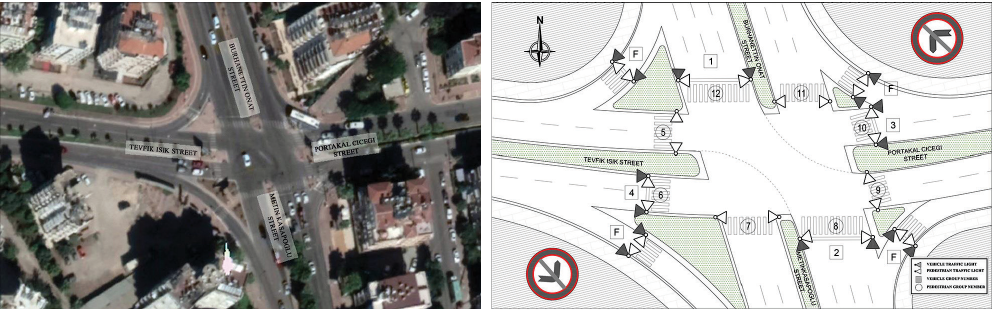
Figure 2. The image and plan view of Burhanettin Onat Street – Metin Kasapoglu Street roundabout in current status (by maps.google.com and by S. Ilyas, Y. User,